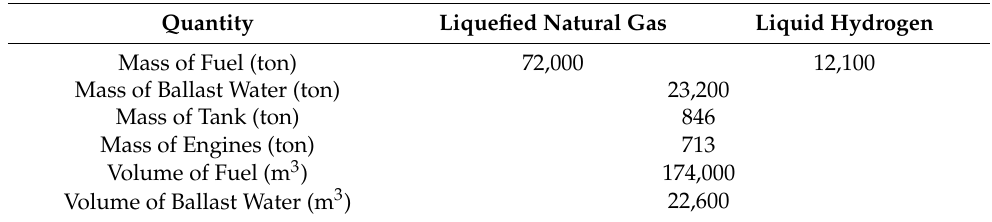
Table 9. Component mass and volume estimates for the conventional liquefied natural gas ship and a liquid hydrogen ship with the same tank insulation